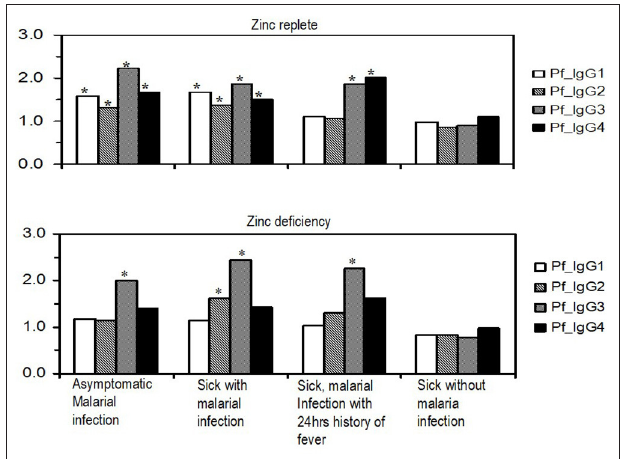
FIGURE 1 | Variations in profile of relative plasma concentrations of malaria parasite-specific IgG subclasses in different malaria situations with and without associated clinical features in zinc-replete and zinc-deficient children. Values on the y-axis are log-transformed values of antibody titers as detected in plasma. Bars with asterisks (*) indicate significance at p ≤